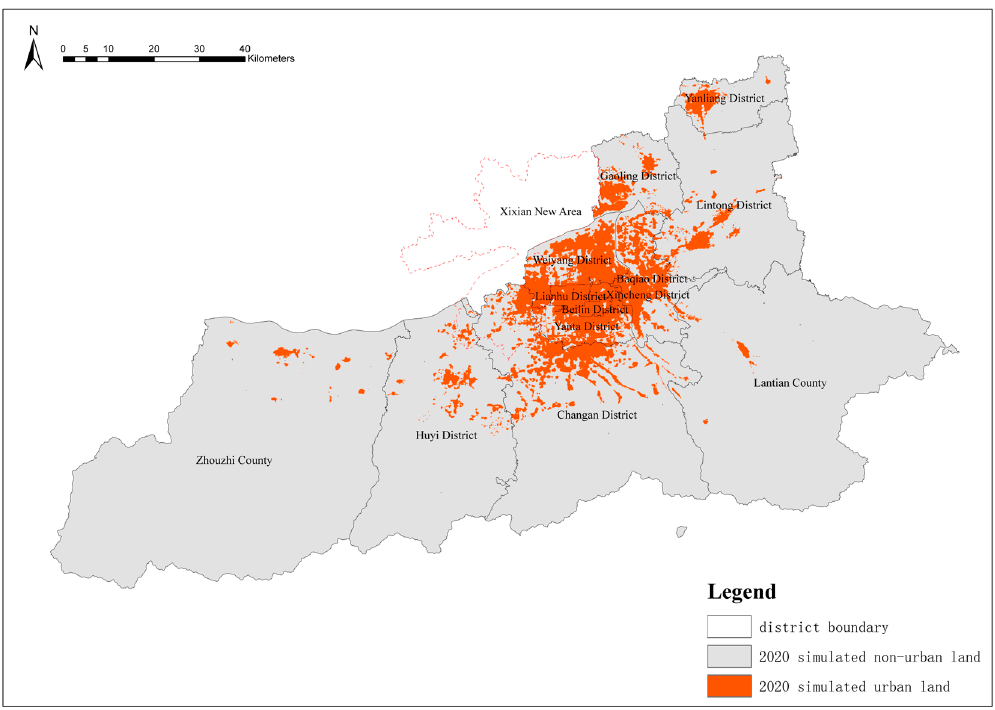
Figure 5. Urban growth simulation in 2020.